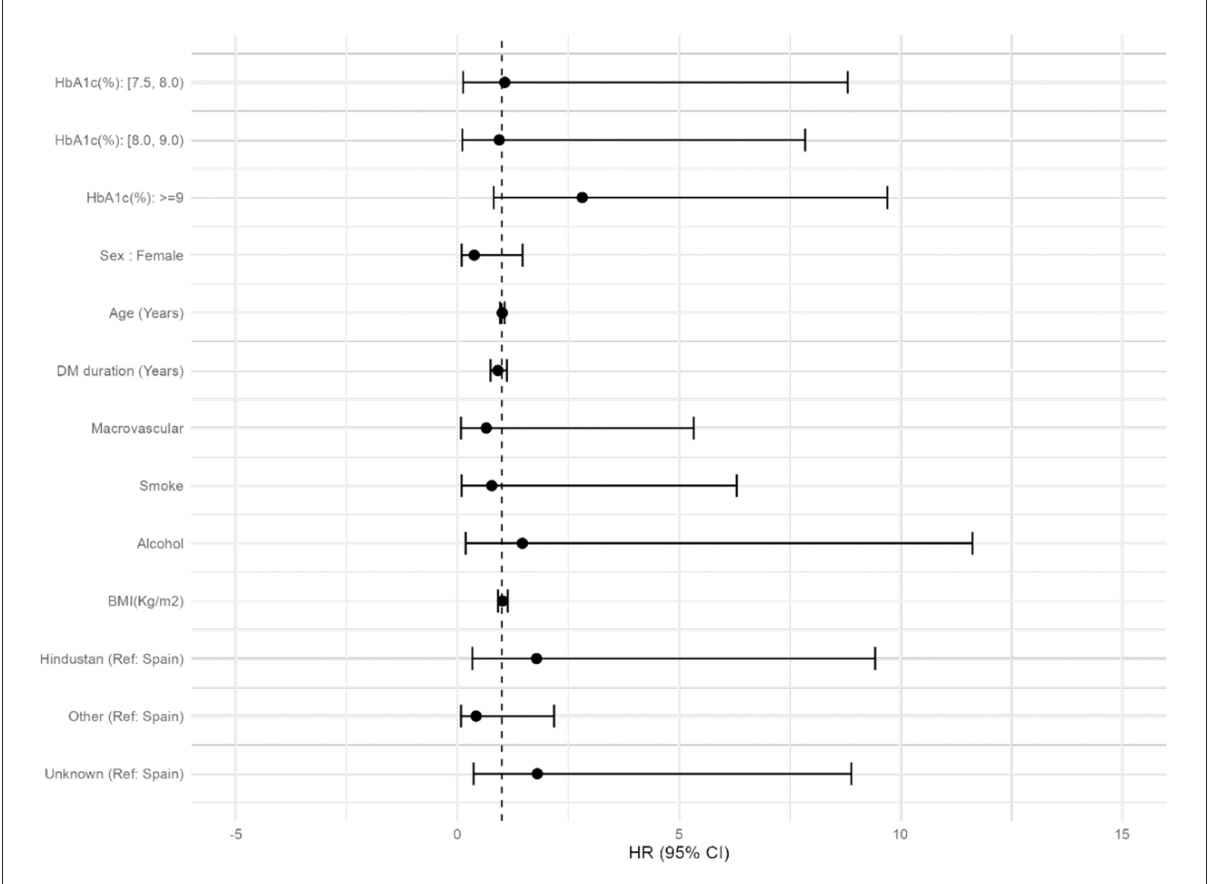
FIGURE3 Forest plot of the factors associated with DM that can influence the appearance of TB.